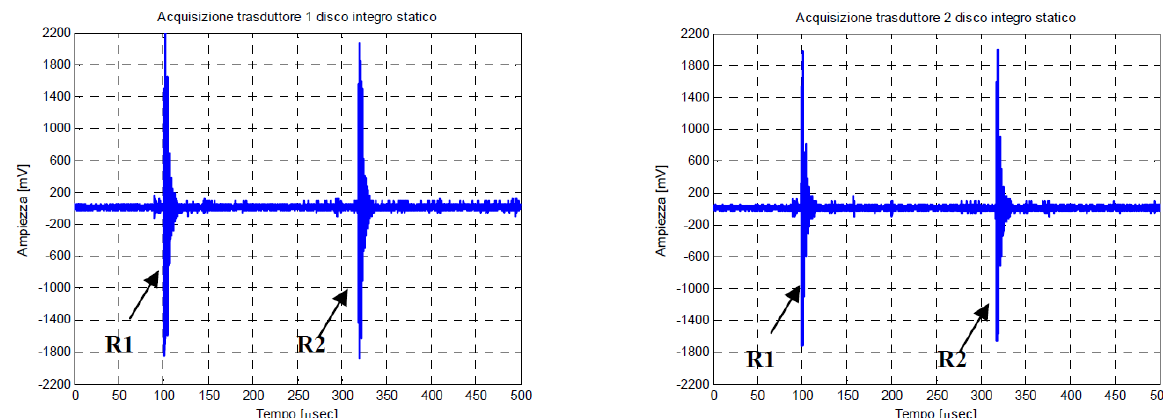
Figura 2: Segnale acquisito dai trasduttori 1 e 2 sul disco integro in condizioni statiche. Figure 2: Signal acquired by transducers 1 and 2 in the pristine disk in static conditions..